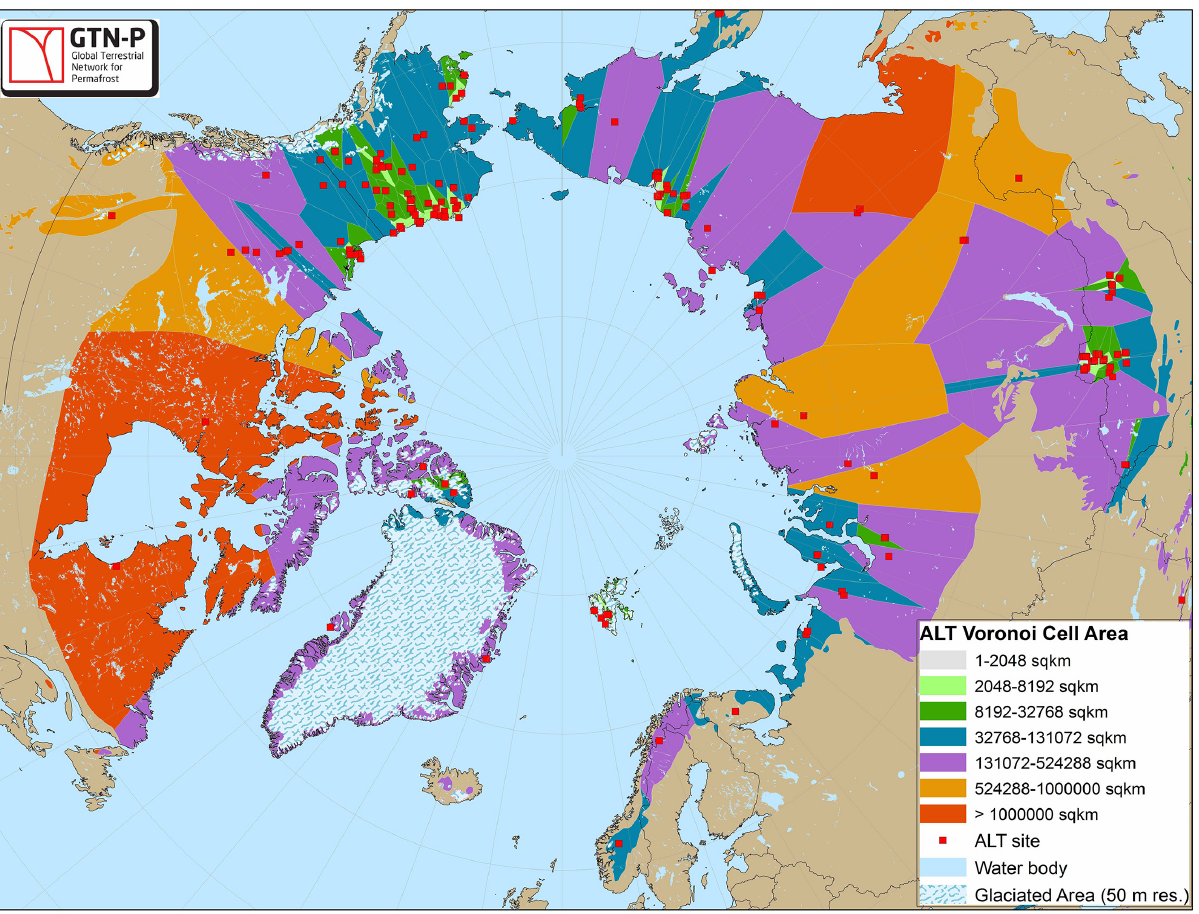
Figure 5. Voronoi tessellation analysis on the distribution of active layer monitoring sites (ALT) in the